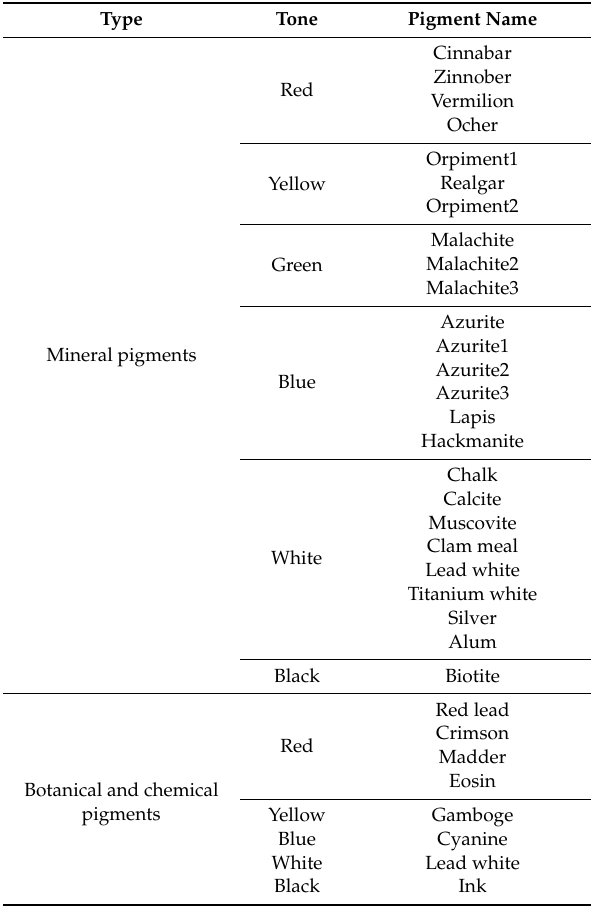
Table 1. Pigments selected for samples